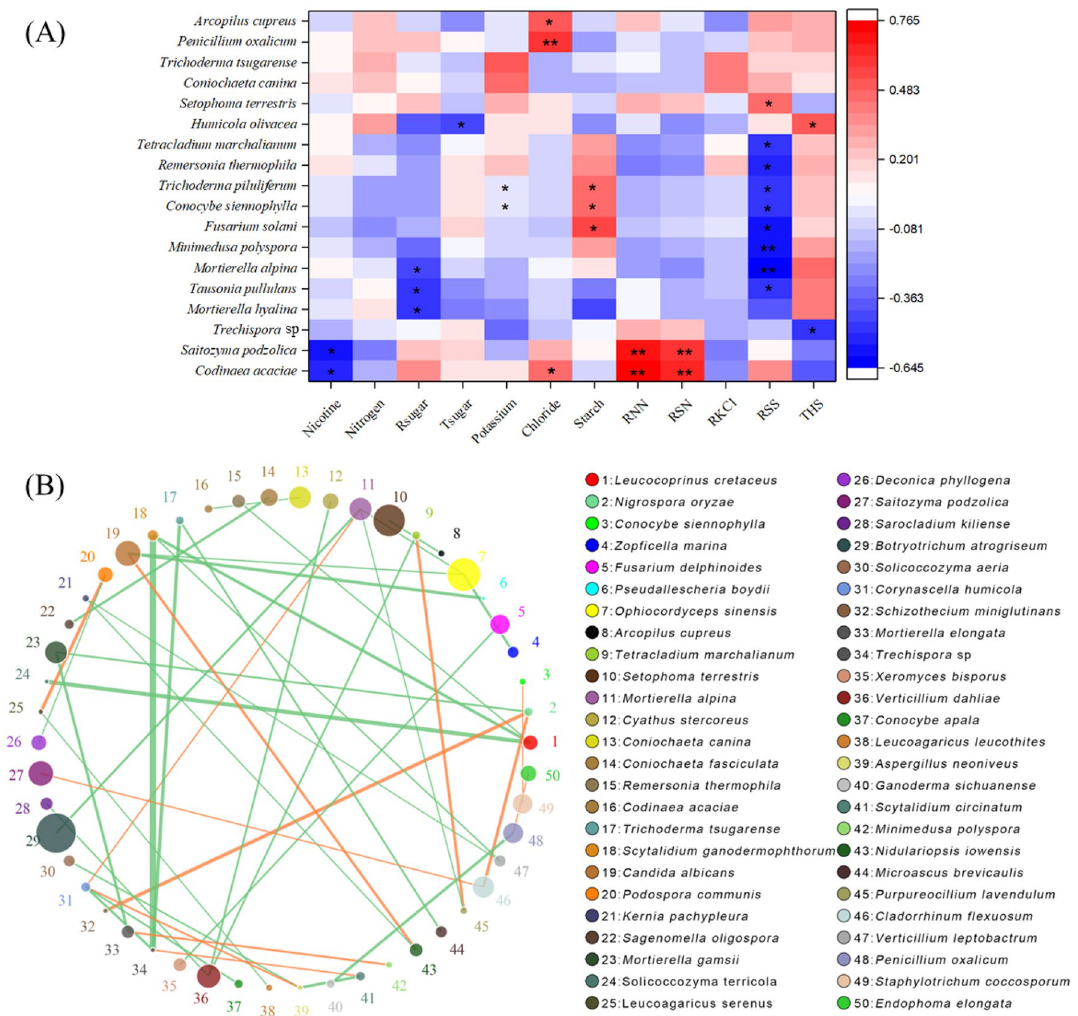
Figure 5. Relationships of fungal richness at species level with quality of tobacco leaves ( A ) and the network at species level ( B ). Tobacco chemical components includes nicotine, nitrogen, reducing sugar (Rsugar), total sugar (Tsugar), potassium, starch, ratio of nitrogen to nicotine (RNN), ratio of reducing sugar to nicotine (RSN), ratio of potassium to chloride (RKCl), ratio of reducing sugar to total sugar (RSS), and total harmony scores (THS). The analyses were constructed using the top 60 most abundant species of soil fungal community, the displayed in the picture was at the significant of p < 0.05 level with r ≥ 0.2. Circles represents species, size of circle represents the abundance. The edges represent the correlation between the two species, the thickness of the edge represents the strength of the correlation, and the color of the line: orange represents the positive correlation, while green represents the negative